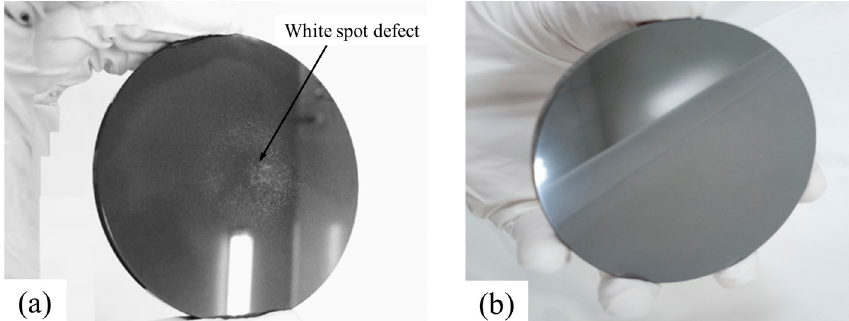
Figure 8. Comparison chart of surface quality with different liquid supply methods. ( a ) External Figure 8. C omparison chart of surface quality with di ff erent liquid supply methods. ( a ) External Figure 8. C omparison chart of surface quality with di ff erent liquid supply methods. ( a ) External Figure 8. C omparison chart of surface quality with di ff erent liquid supply methods. ( a ) External liquid supply; ( b ) internal liquid supply. liquid supply; ( b ) internal liquid supply. liquid supply; ( b ) internal liquid supply. liquid supply; ( b ) internal liquid supply.